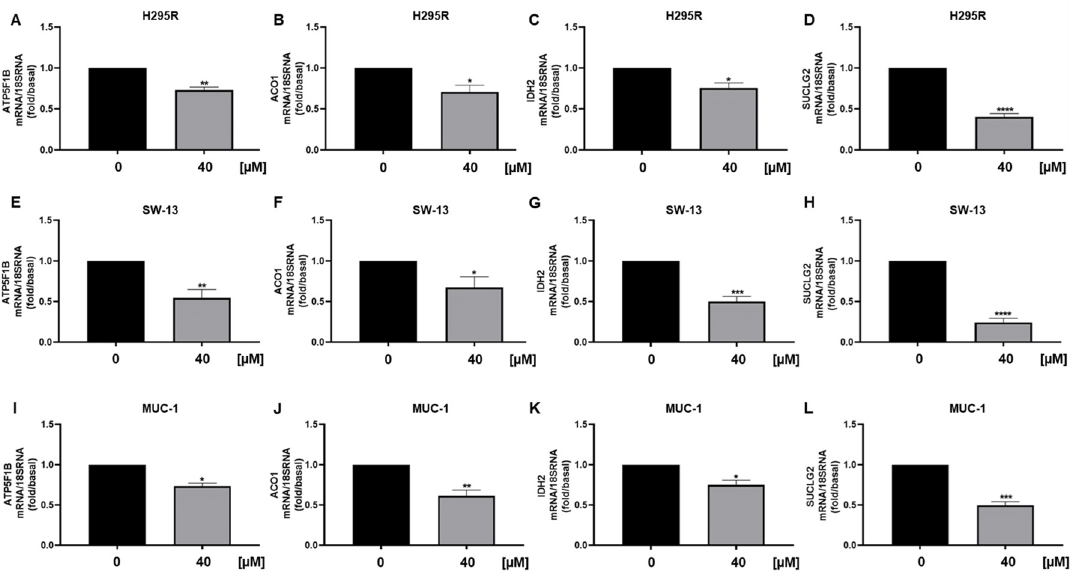
Figure 8. Curcumin effects on TCA gene expression in ACC cells. Real ‐ time RT ‐ PCR for ATP5F1B, ACO1, IDH2, SUCLG2 gene expression in H295R cells ( A – D ), SW ‐ 13 cell ( E – H ) and MUC ‐ 1 cells ( I – L ) treated with curcumin (40 μ M) for 24 h. Data represent the mean ± SE of values from at least three independent RNA samples (* p < 0.05; ** p < 0.01; *** p < 0.001; **** p < 0. 0001 vs. 0 μ M).